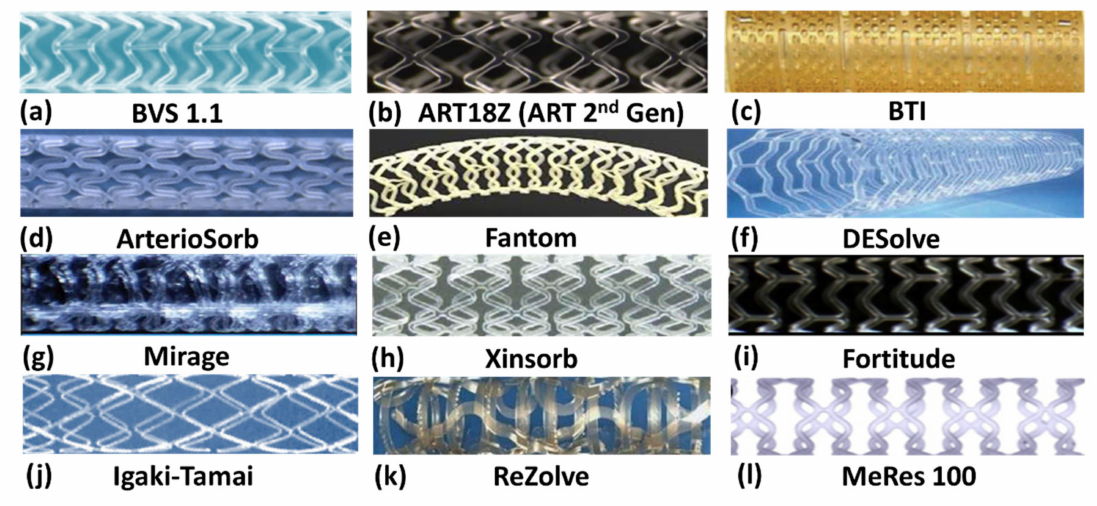
Figure 3. BRS in development, the preclinical or clinical phase. ( a ) Abbott Vascular’s ABSORB BVS 1.1, ( b ) Arterial Remodelling Technologies’ ART18Z (2nd generation), ( c ) Bioabsorbable Therapeutics Inc’s (BTI) stent, ( d ) Arterius’ ArterioSorb, ( e ) REVA Medical’s Fantom, ( f ) Elixir Medical’s DESolve, ( g ) Manli Cardiology’s MIRAGE, ( h ) HuaAn Biotech’s Xinsorb, ( i ) Amaranth’s Fortitude, ( j )